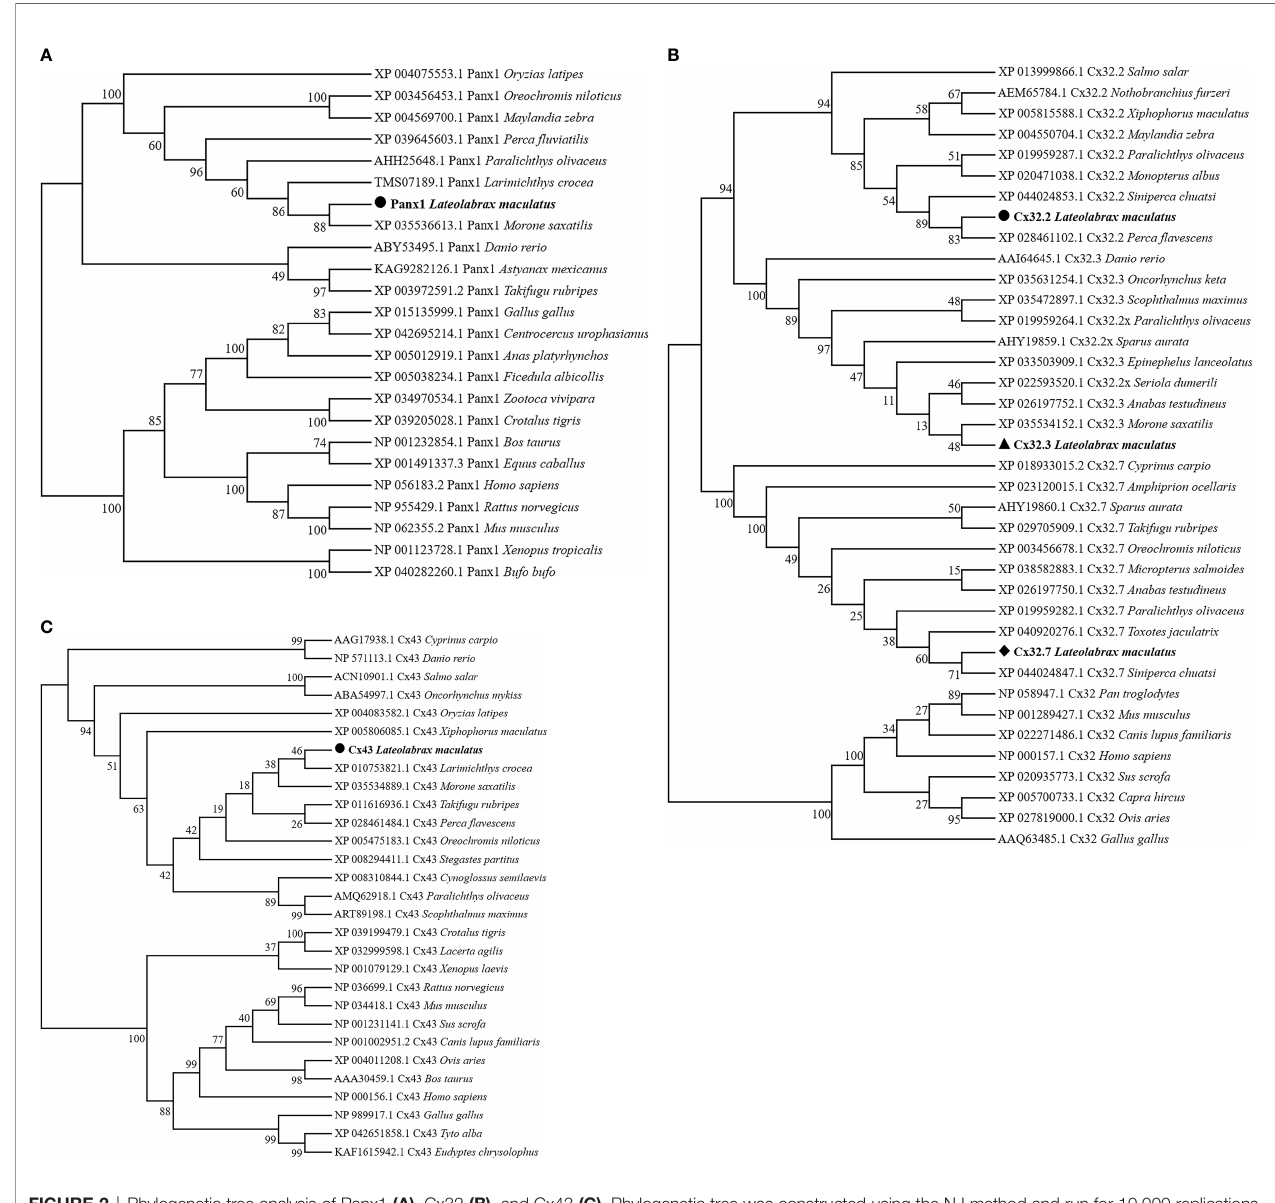
FIGURE 2 | Phylogenetic tree analysis of Panx1 (A) , Cx32 (B) , and Cx43 (C) . Phylogenetic tree was constructed using the NJ method and run for 10,000 replications. The Lm Panx1, Lm Cx32, and Lm Cx43 are shown in